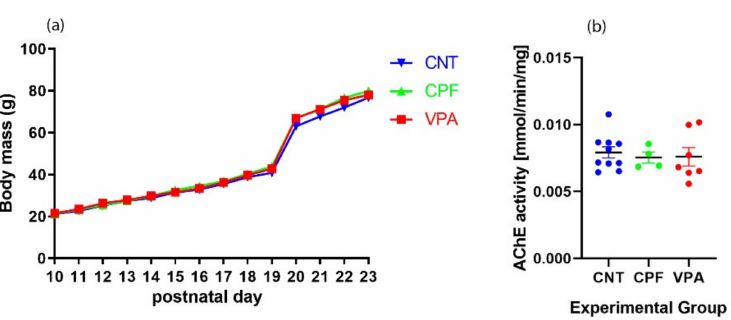
Figure 1. ( a ) Body weight gain as a function of days. There were no significant di ff erences in weight evolution in relation to the di ff erent prenatal treatments received by each group; ( b ) E ff ects of prenatal treatment on the expression of AChE. There were no significant di ff erences between the groups. The data are expressed as a ratio of concentration of average control ± SEM. Each dot or square represents an individual animal (CNT = 10; CPF = 4; VPA =